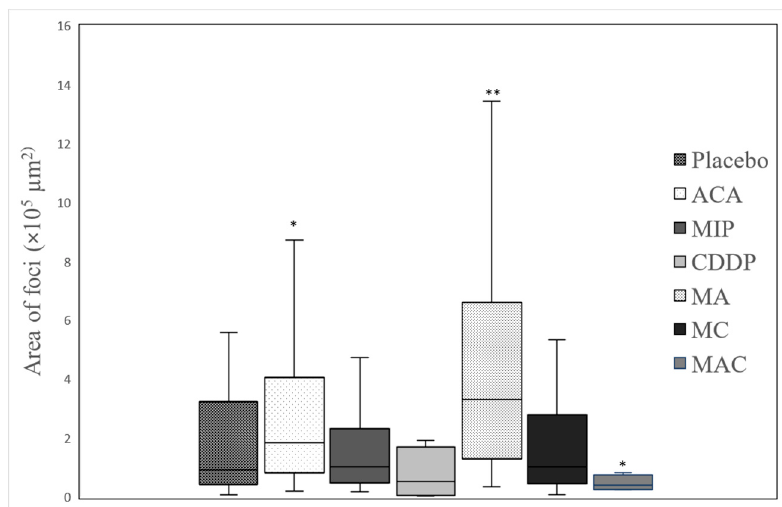
Figure 4. Distribution of the size of tumor foci in lung metastases in BALB/c mice with breast cancer after treatment with a placebo, 1 ′ -S-1 ′ -acetoxychavicol acetate (ACA), Mycobacterium indicus pranii (MIP), cisplatin (CDDP), ACA/MIP (MA), CDDP/MIP (MC), and ACA/MIP/CDDP (MAC). Statistically significant differences between placebo and treatment groups after applying the Mann–Whitney test are indicated as * for p < 0.05 and ** for p < 0.01.